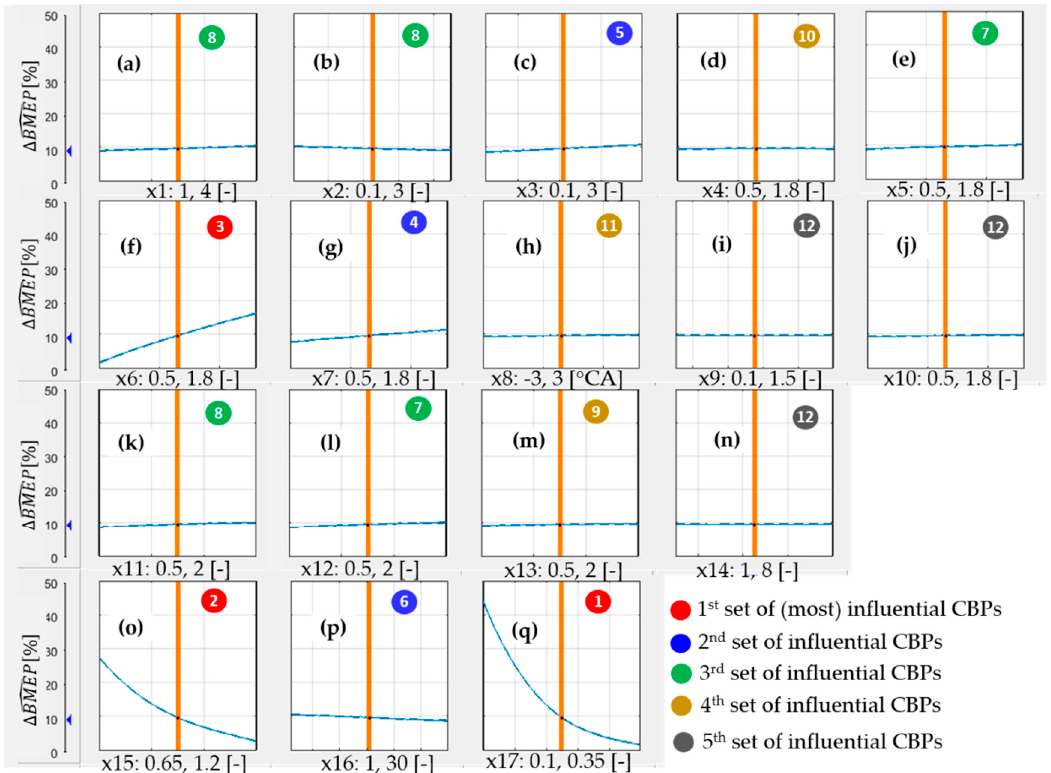
Figure 5. Slices of the ∆(cid:1828)(cid:1839)(cid:1831)(cid:1842)(cid:3555) surface response model (Equation (34)) at 3800 rpm, full ‐ load operating point depending on CBPs (x1–x17) listed in Table 1 at given lower and upper bounds. Ascending numbers in colored circles represent the grade of influence of the certain CBP (smaller number, bigger influence): ( a ) Air cleaner FrMp ; ( b ) Intercooler FrMp ; ( c ) Intercooler HTMp ;